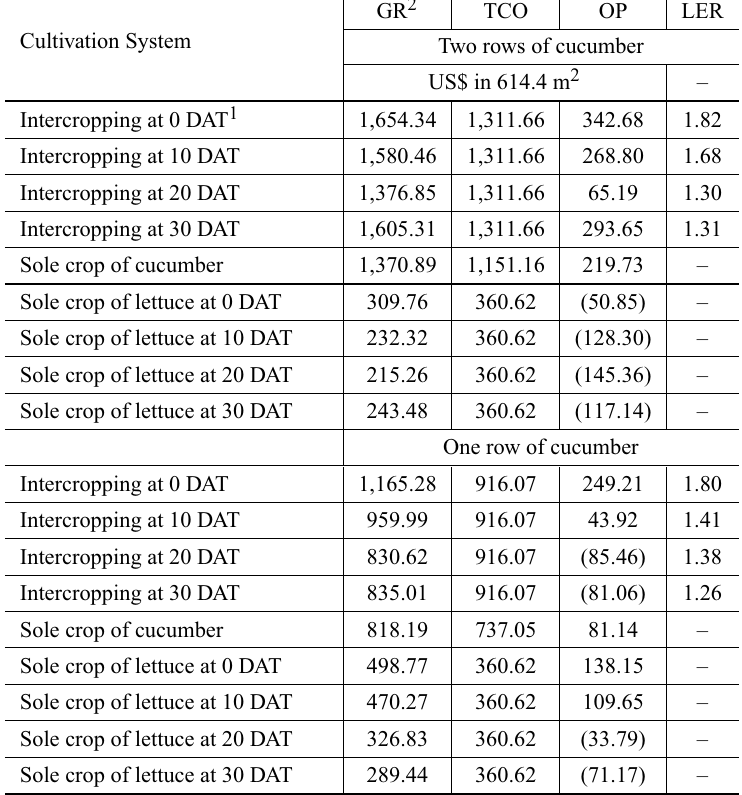
Gross revenue (GR), Total cost of operations (TCO), Operating profit (OP) and Land Equivalent Ratio (LER) of lettuce ‘Verônica’ and Japanese cucumber ‘Hokushin’ cultivated in two and one row on the bed in intercropping and sole crop. Jaboticabal, SP, Brazil, 2007. Cultivation